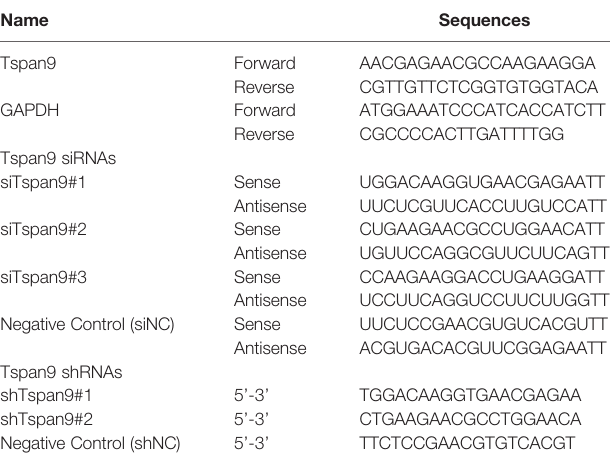
TABLE 1 | The siRNA and shRNA sequences used in this